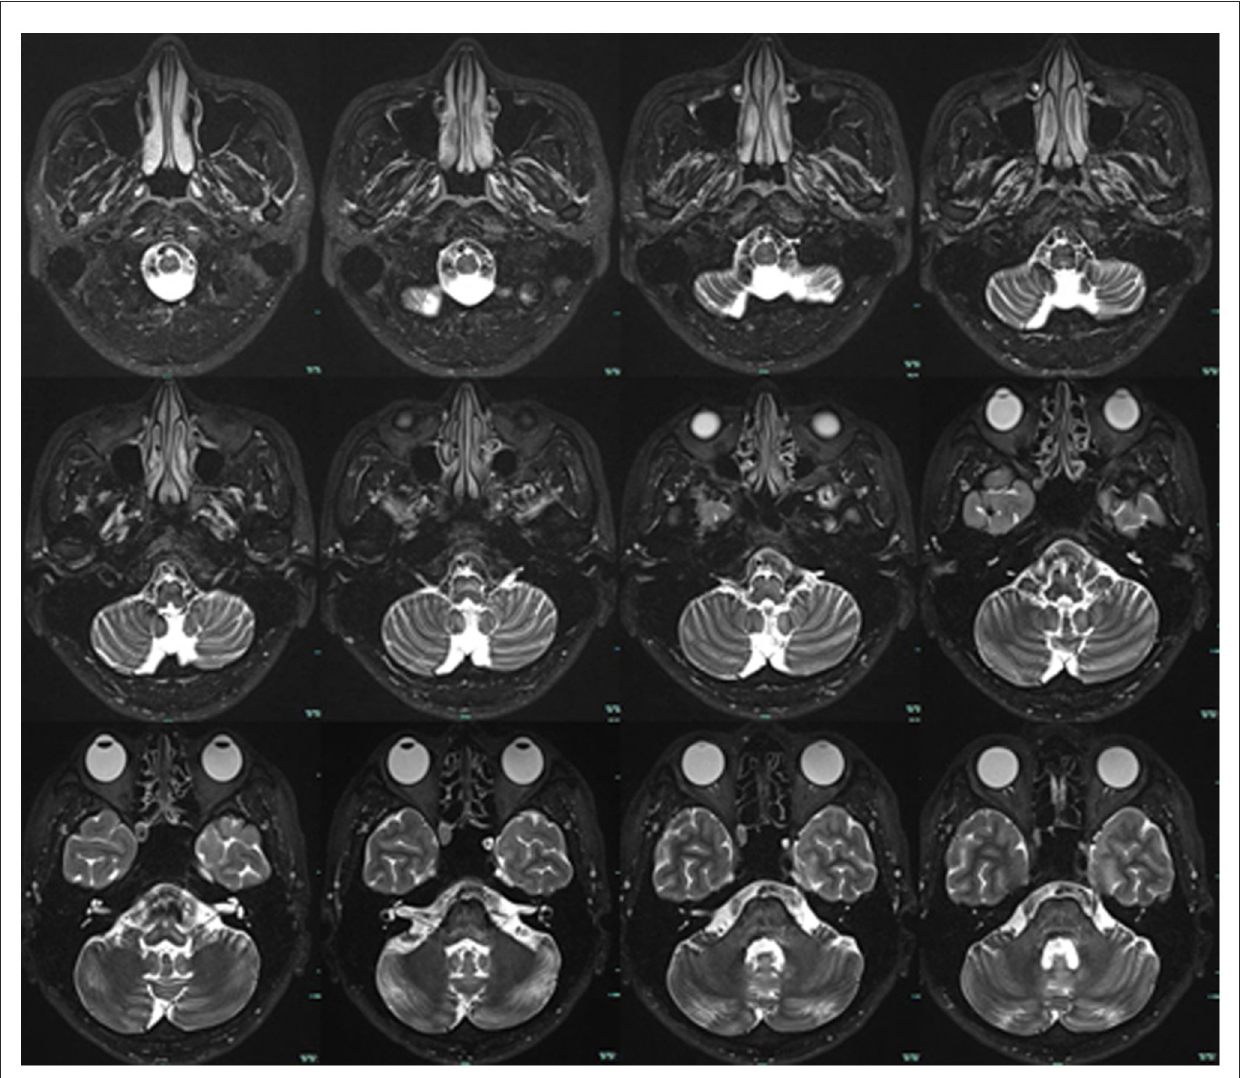
FIGURE2 Brain MRI. T2-weighted sequences showed no tumor or other lesions in the cerebello-pontine angle and brainstem.